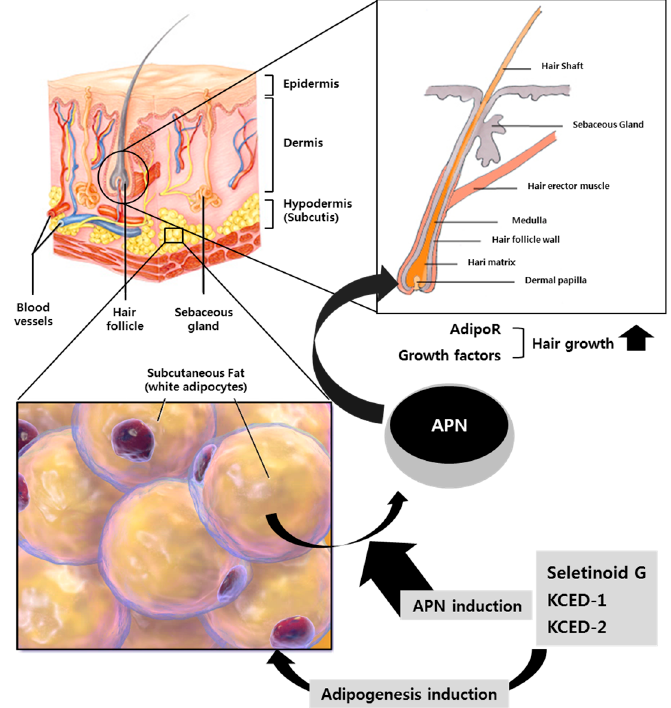
Figure 6. Schematic diagram illustrating the roles of kojyl cinnamate ester derivatives in adipogenesis and hair growth. Kojyl cinnamate ester derivatives including SG, KCED-1, and KCED-2 can promote adipogenesis and induction of APN mRNA levels and secretion of APN protein from human subcutaneous fat tissue. The secreted APN can promote hair growth via APN